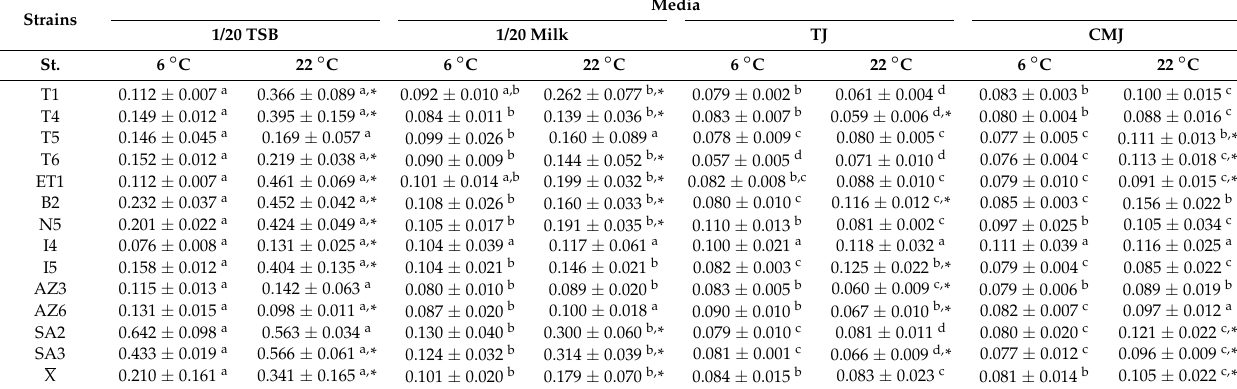
Different letters in the same row and the same temperature indicate significant differences ( p < 0.05). Asterisks indicate significant differences ( p < 0.05) between the two temperatures for the same growth medium. Strains code corresponds to those in Table 1. St.: strains; X: Average. Tryptic Soy Broth